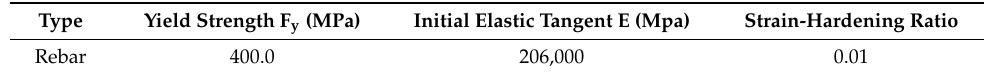
Table 2. Parameters of Rebar